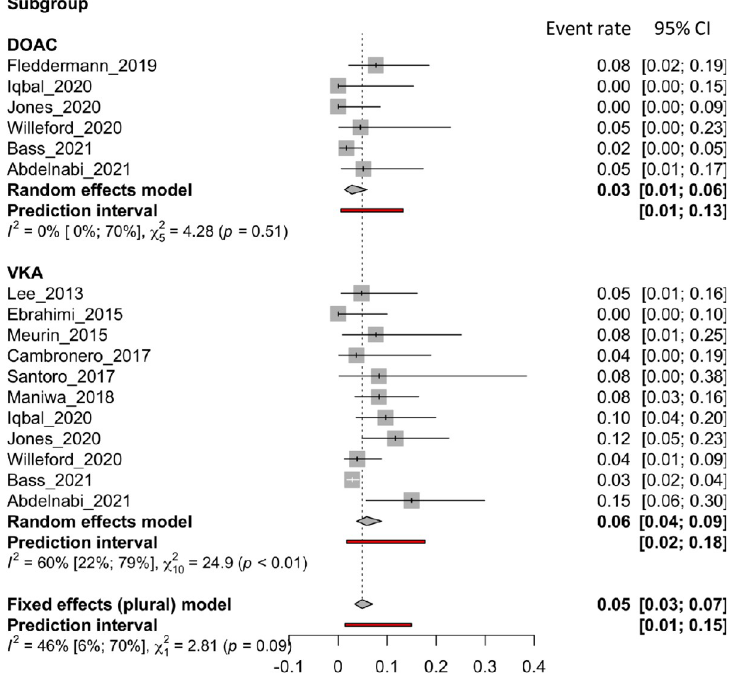
Fig 5. Forest plot of the proportion of major bleeding rate for VKA and DOAC